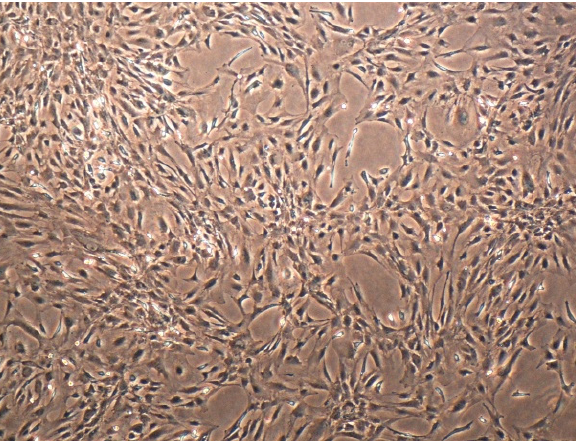
Figure 4. The culture of glioblastoma cells isolated from the resection specimen. A characteristic polymorphic cell appearance with sparse cytoplasm and differently shaped nuclei are seen. Nicon Diaphot 300 inverted microscope. Scale bar = 100 µm.